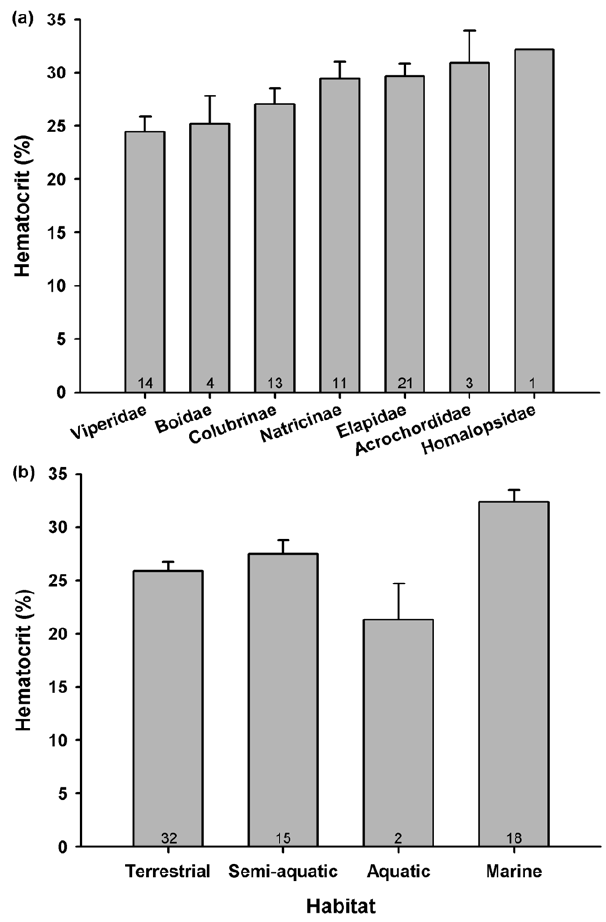
Figure 2. Hct (simple mean ± SE) in relation to family (a) and habitat (b). Numbers in the bars indicate sample size (number of species).